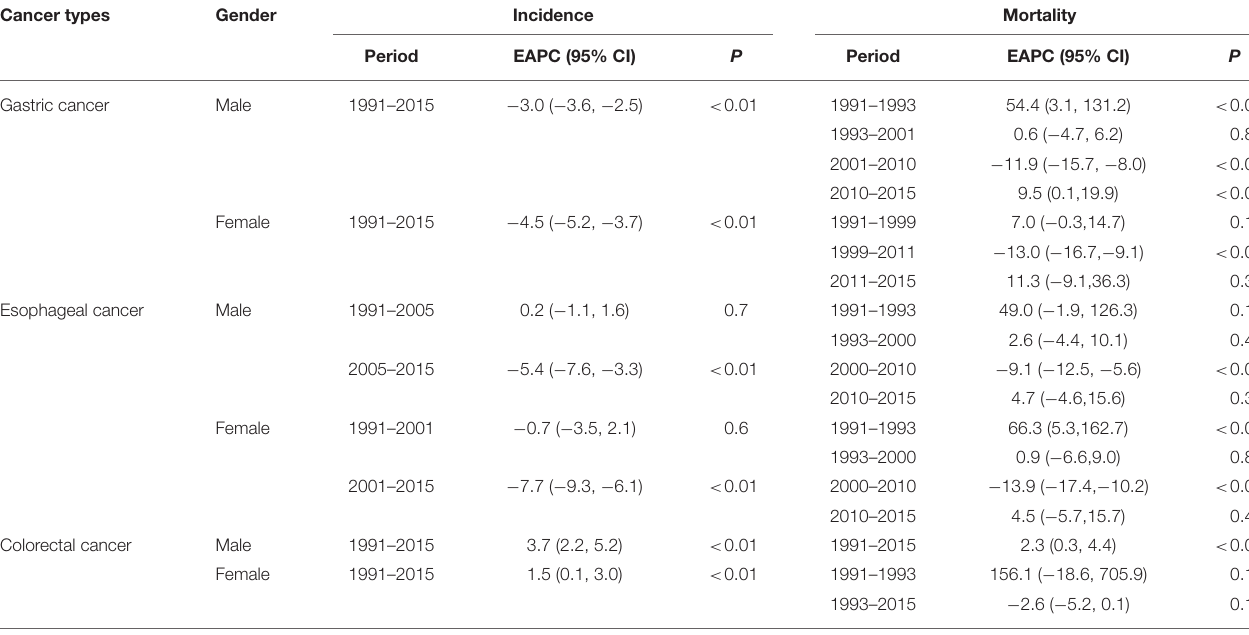
TABLE 2 | Joinpoint analysis of gastrointestinal cancers in Yangzhong, 1991–2015. Cancer types